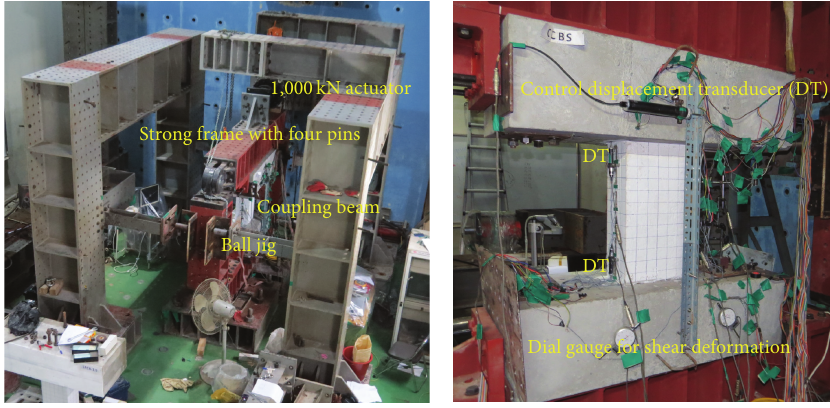
Figure 5: Test setup for coupling